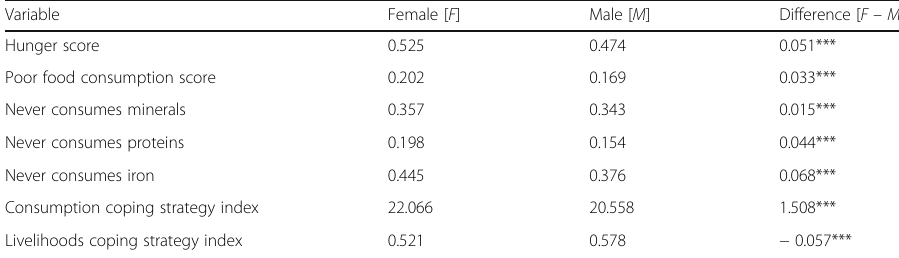
Table 4 Food security by gender of the household head